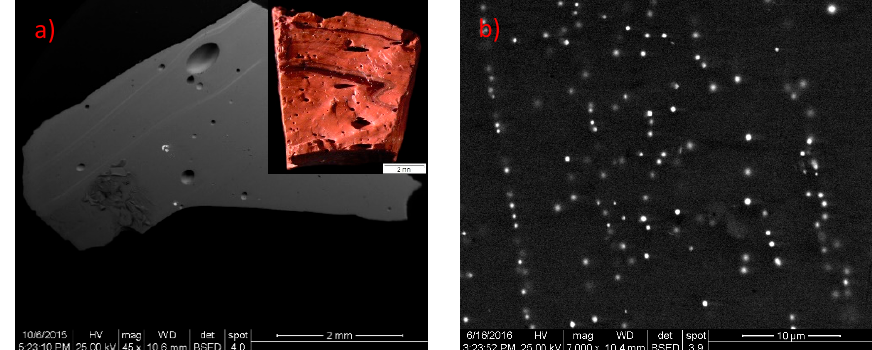
Figure 40. EDS spectrum acquired on the rounded inclusions, exclusively made of Cu (KH_R1 red natron-based Egypt I glass tessera from Khirbet al-Mafjar, Palestine [23]).